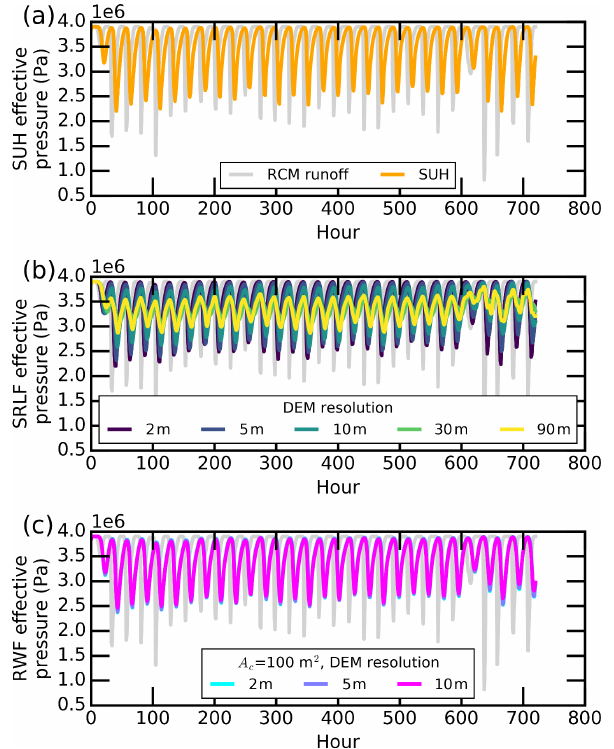
Figure 3. Subglacial effective pressures for IDC1 as simulated by SHAKTI, with inputs to the subglacial system via a single moulin prescribed by the moulin discharges (shown in Fig. 2) generated by the various surface meltwater routing models. The effective pres- sure shown is the spatial mean over the entire 1km square domain, which contains the moulin input at its center.